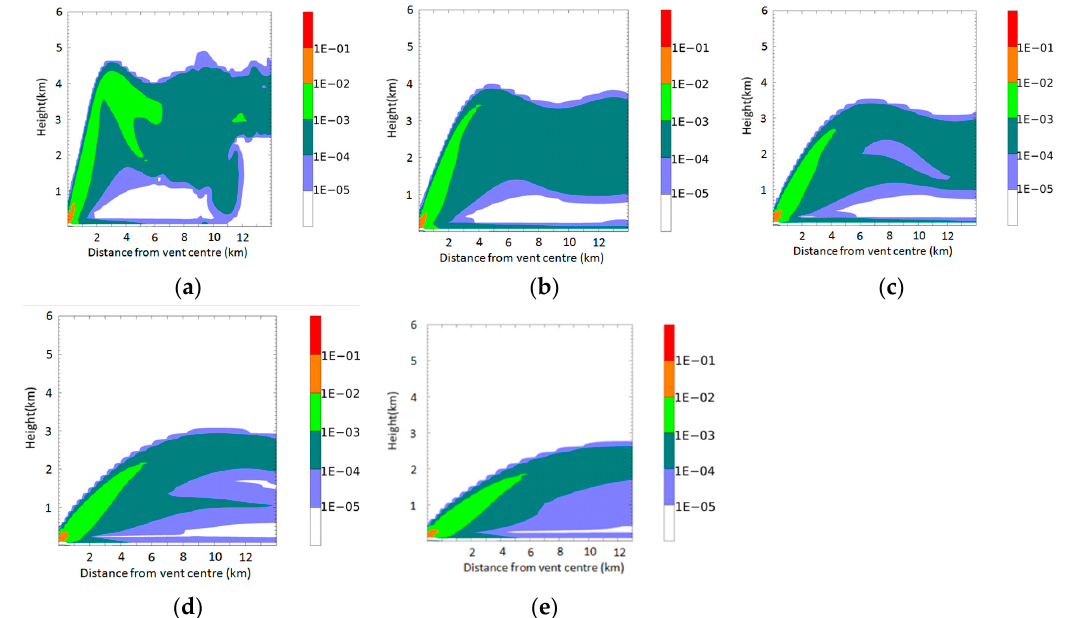
Figure 9. Dependence of plume height for background wind speeds (constant shear rate) of ( a ) 1 × 10 − 3 s − 1 , ( b ) 1.5 × 10 − 3 s − 1 , ( c ) 2 × 10 − 3 s − 1 , ( d ) 3 × 10 − 3 s − 1 and ( e ) 4 × 10 − 3 s − 1 . Results are for t = 1200 s after eruption. The non-dimensional values of W (see text) are ( a ) 0.1, ( b ) 0.15, ( c ) 0.2, ( d ) 0.3 and ( e ) 0.4. Atmosphere 2020 , 11 , x FOR PEER REVIEW